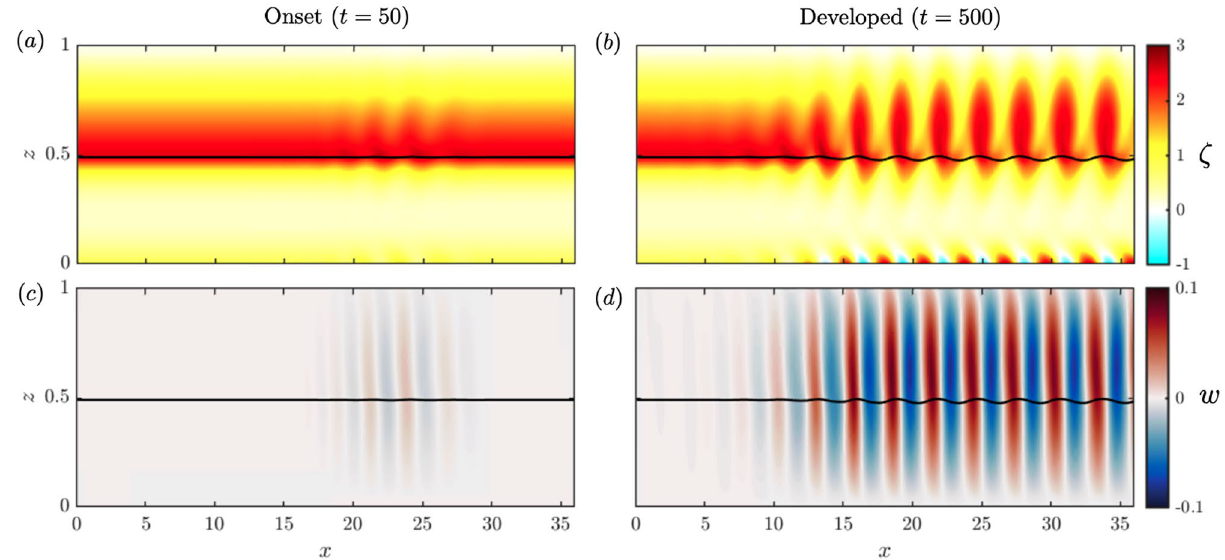
Figure 3. Instability onset at t = 50 ( a , c ), and developed, long-term behavior at t = 500 ( b , d ), for Re = 1000 , β = 0.10 , r = 0.5 , (cid:31) = 1 , and Fr 2 = 0.1 . ( a , b ) Vorticity field ζ = ∂ z u − ∂ x w , and ( c , d ) vertical velocity w . The solid black lines represent the instantaneous seagrass height h g ( x , t )